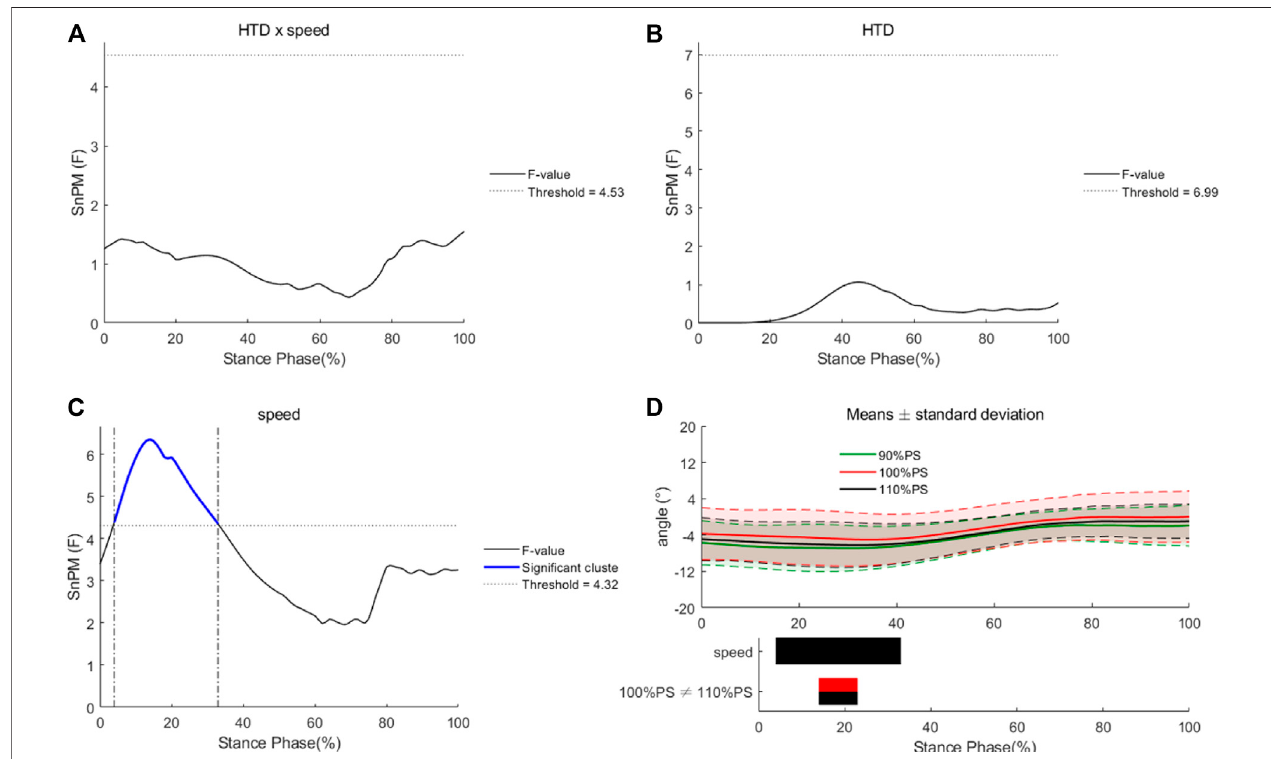
FIGURE 6 | Differences of hip angles in the horizontal plane under different HTDs and running speeds. Interaction (A) , main effects of HTD (B) and speed (C) , and post hoc tests for speed (D) .